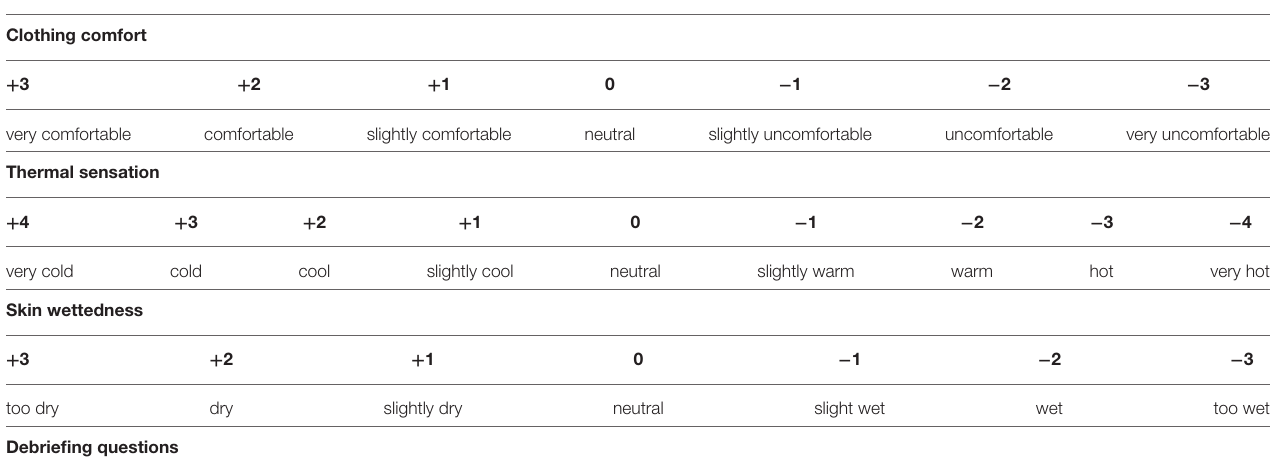
TABLE 3 | Perceptual and debriefing